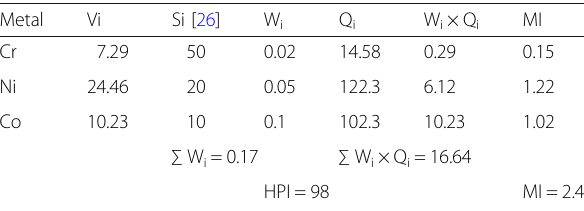
Table 2 Heavy metal pollution index (HPI) and metal index (MI) in freshwater of Rosetta